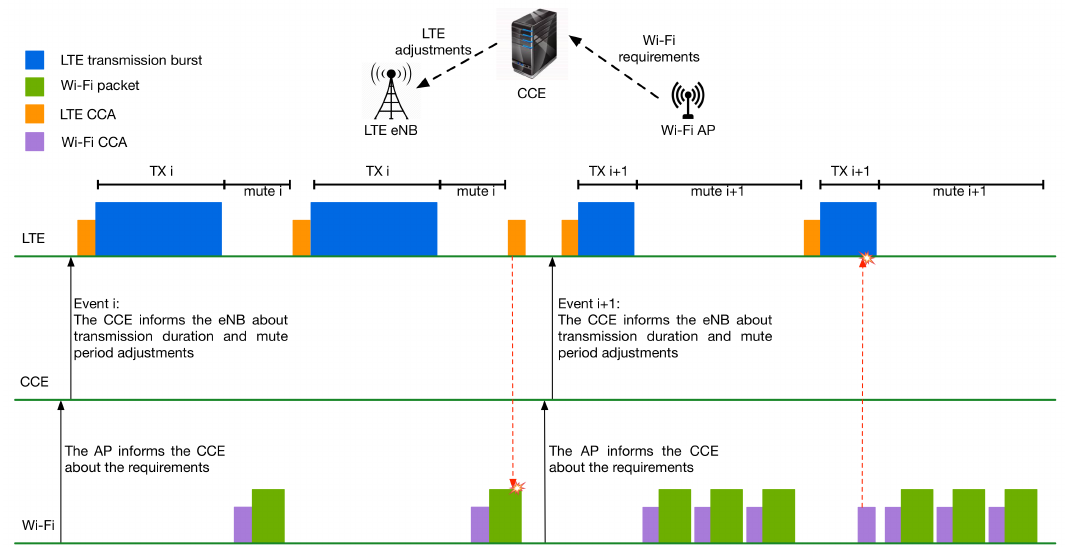
Figure 12. Adjustment of LTE transmission based on Wi-Fi